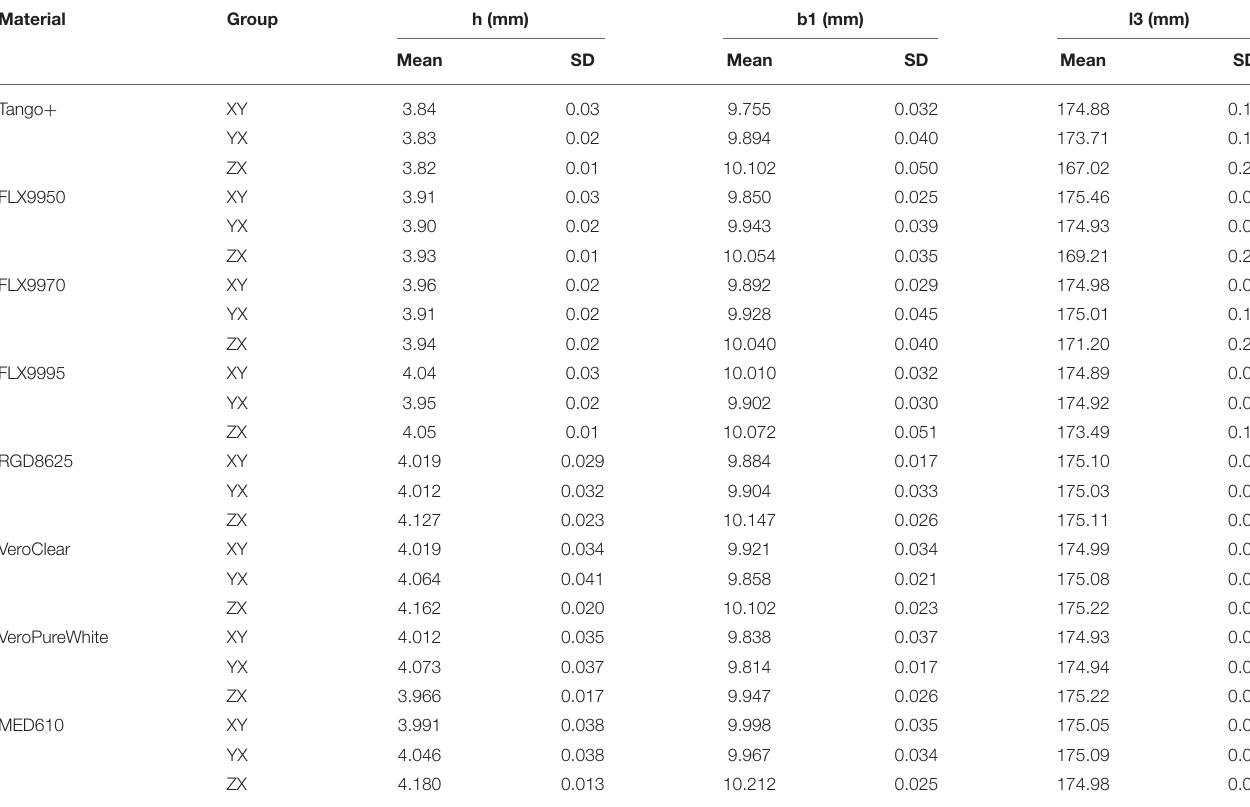
TABLE 4 | Mean dimensional data ( n = 30 for h and b1, n = 6 for l3) and corresponding standard deviations (SD) (h, thickness; b1, width; l3, length of the type 1A tensile specimen).